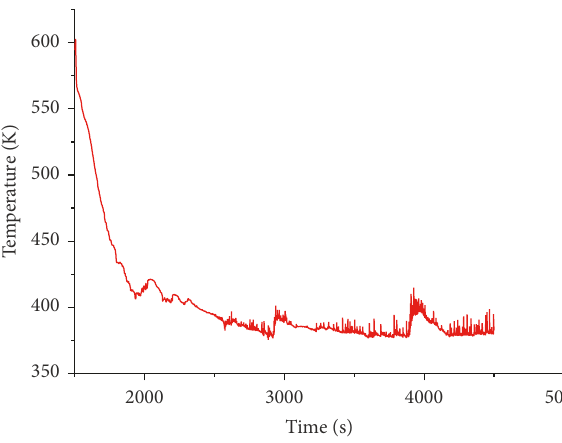
Figure 30: Temperature on the cladding inner wall.